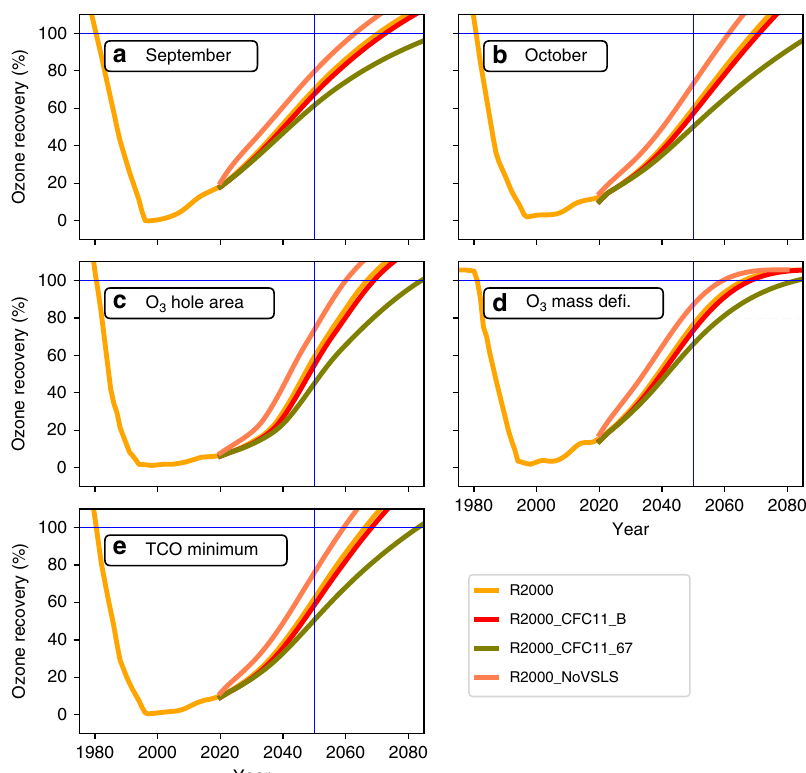
Fig. 5 Extent of recovery for Antarctic ozone hole showing the in fl uence of varying chlorine loading. Extent of recovery (%) for the metrics of a September mean column ozone (90 o S – 60 o S), b October mean column ozone, c area contained within the 220 DU contour (averaged September 7 – October 13), d ozone mass de fi cit (averaged September 21 – October 13) and e minimum column ozone (between September 21 and October 16) from TOMCAT simulations R2000 (2000 meteorology), R2000_CFC11_B (with additional CFC-11 emissions from box model), R2000_CFC11_67 (with constant CFC-11 emissions of 67 Gg yr − 1 ) and R2000_NoVSLS (no chlorinated very short-lived substances) (see legend) from 1980 to 2080. For the metrics 0%